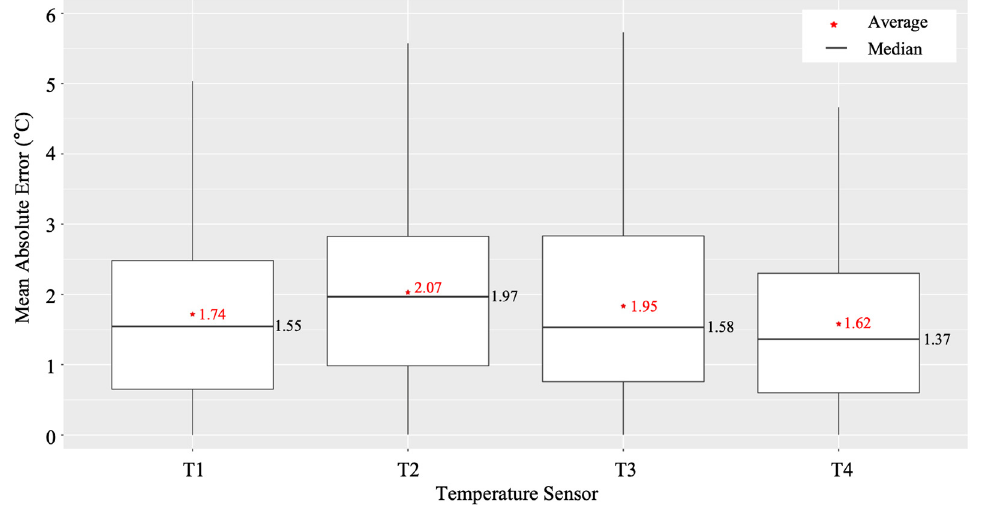
Figure 14. Mean Absolute Error (MAE) of each temperature sensor between actual daily average temperature and predicted daily average temperature.